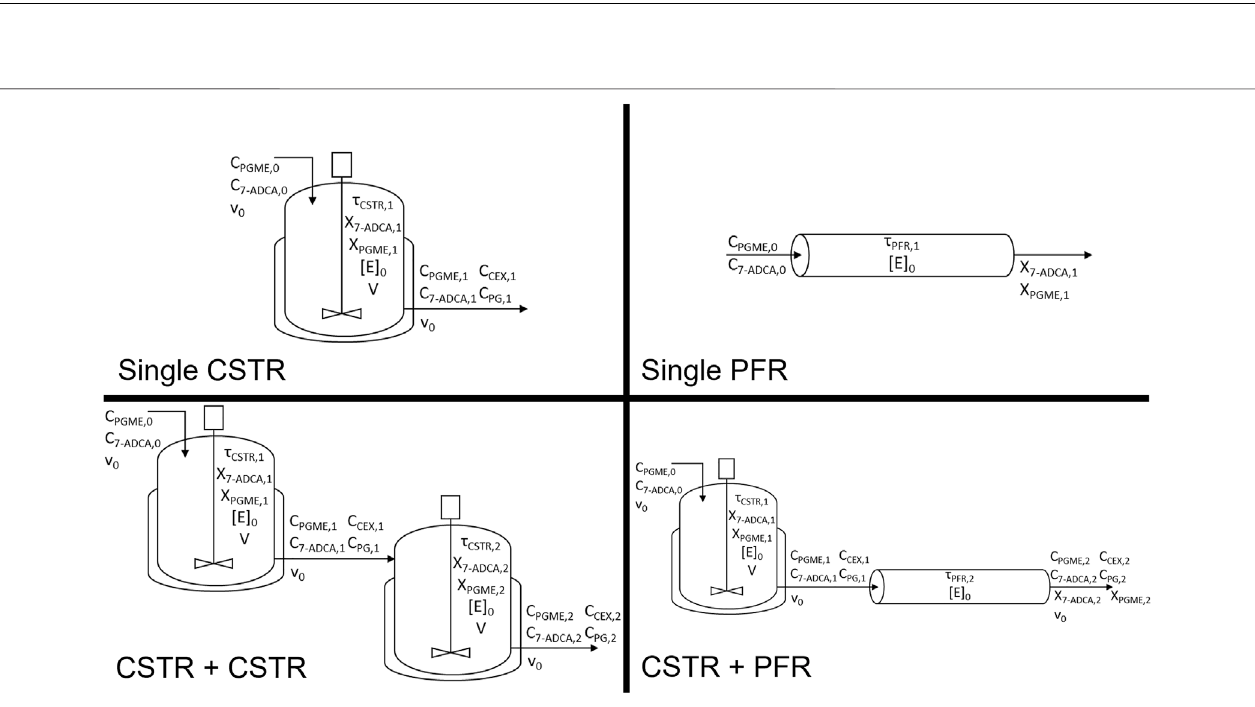
Frontiers in Bioengineering and Biotechnology |